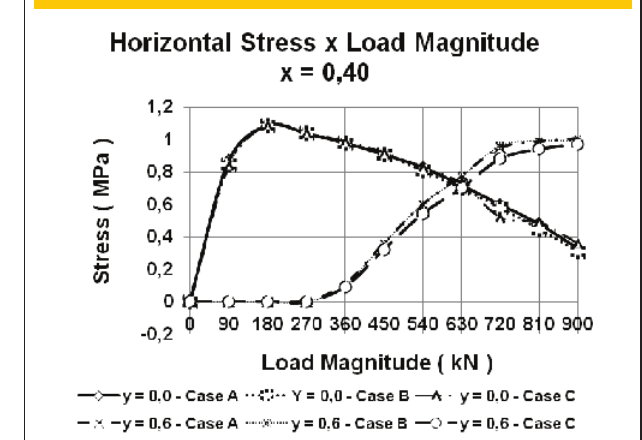
Figure 11 – Horizontal stress versus loading at the section beneath the load aplication